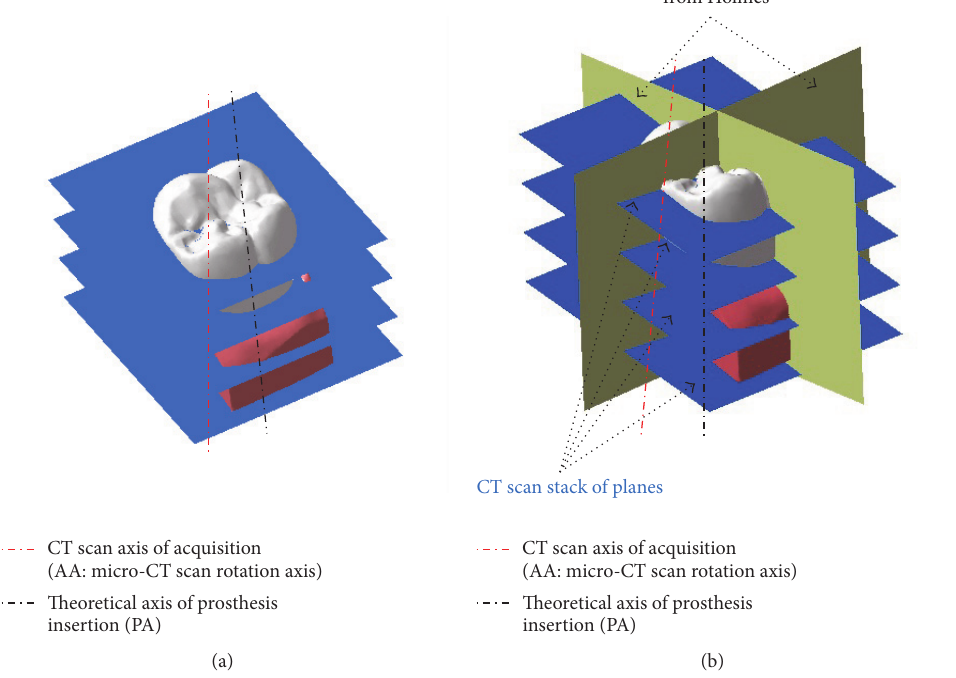
Figure 3: Directions of acquisition versus theoretical directions of